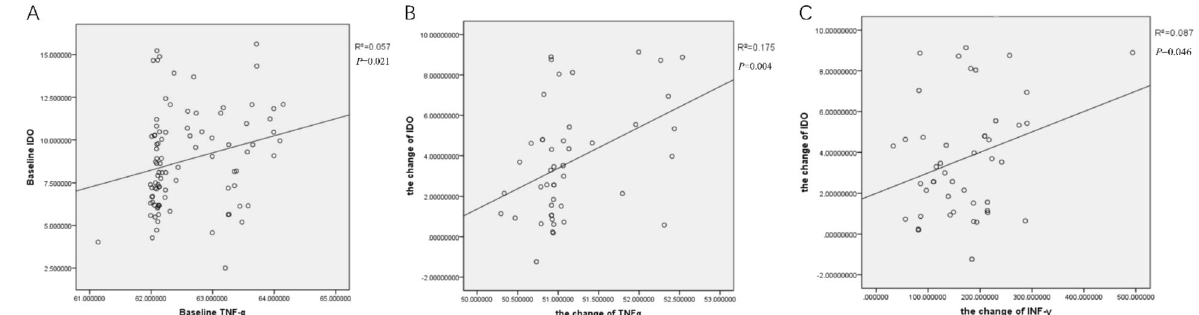
Fig. 4 Correlation coef fi cients between IDO levels and TNF- α and INF- γ levels. A There was a signi fi cant positive correlation between serum IDO levels and serum TNF- α levels in all schizophrenia patients. B The change in IDO levels showed a signi fi cant positive correlation with the decrease in TNF- α levels in the celecoxib group. C The change in IDO levels showed a signi fi cant positive correlation with the decrease in INF- γ levels in the celecoxib group. P <